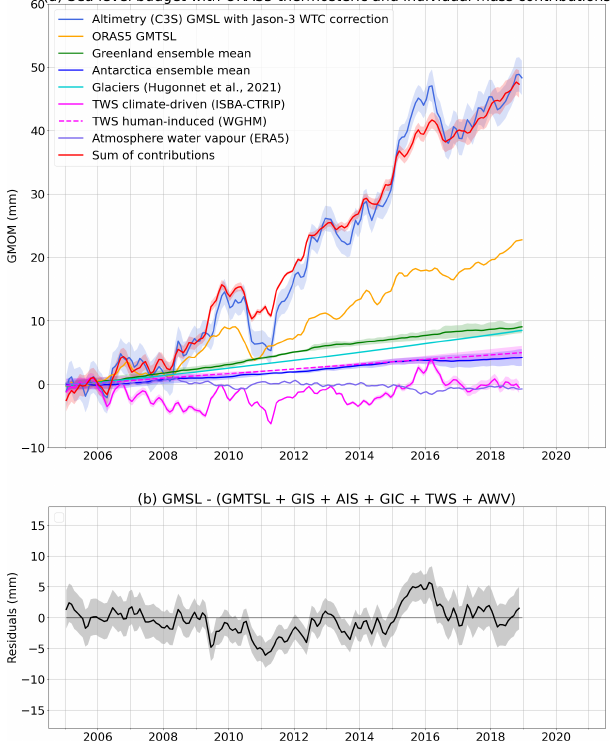
Figure 10. Sea level budget using the individual ocean mass con- tributions. (a) Sea level budget using the ORAS5 GMTSL and tak- ing into account the Jason-3 radiometer drift correction. (b) Budget residuals. Linear trends of all components over different periods of time are provided in Table